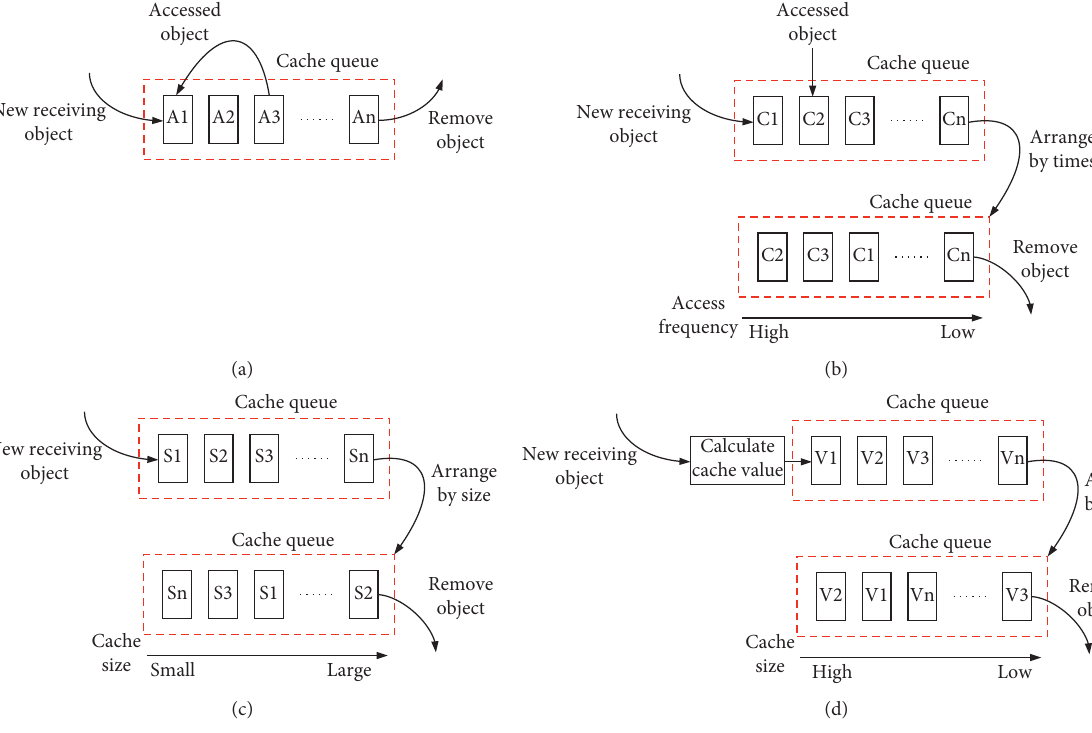
Figure 7: Comparison of several common caching strategies. (a) LRU. (b) LFU. (c) Size. (d) LRV.